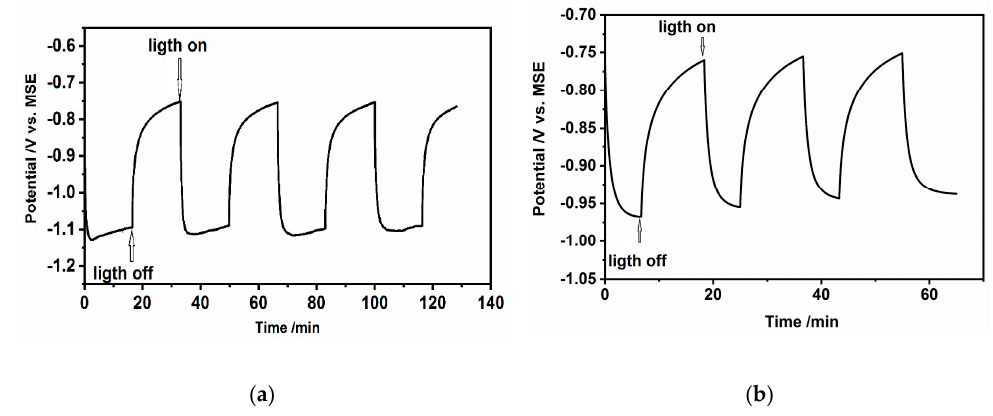
Figure 10. Changes of open circuit potential during illumination of ( a ) CdS hydrophilic drop-cast nanoparticles on ITO, ( b ) L-B layers of hydrophobic CdS nanoparticles deposited on ITO (50 layers) in 0.2 M Na 2 SO 3 /0.1 M Na 2 SO 4 .